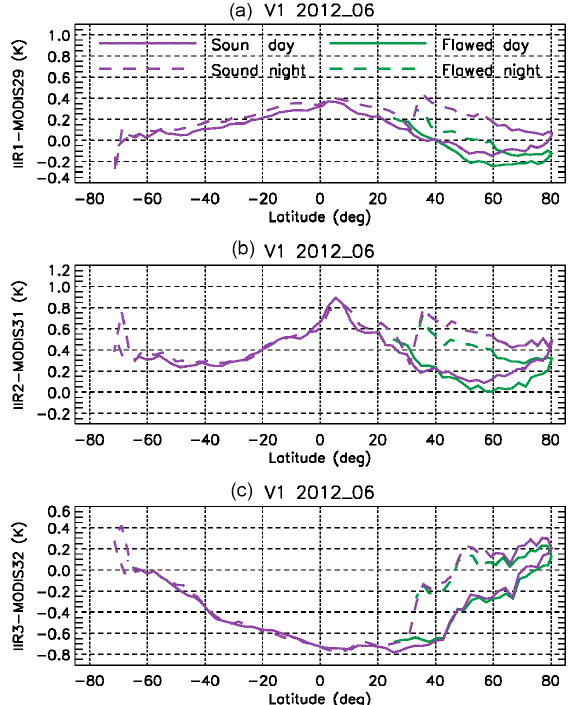
Figure 7. Median IIR Version 1–MODIS C5 BTDs vs.